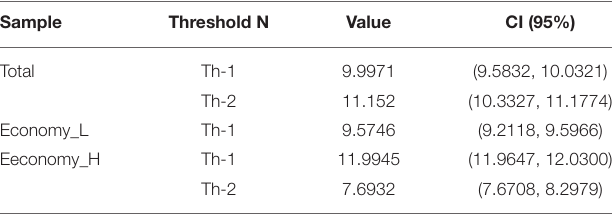
TABLE 8 | Robustness check_ test for threshold value (change X